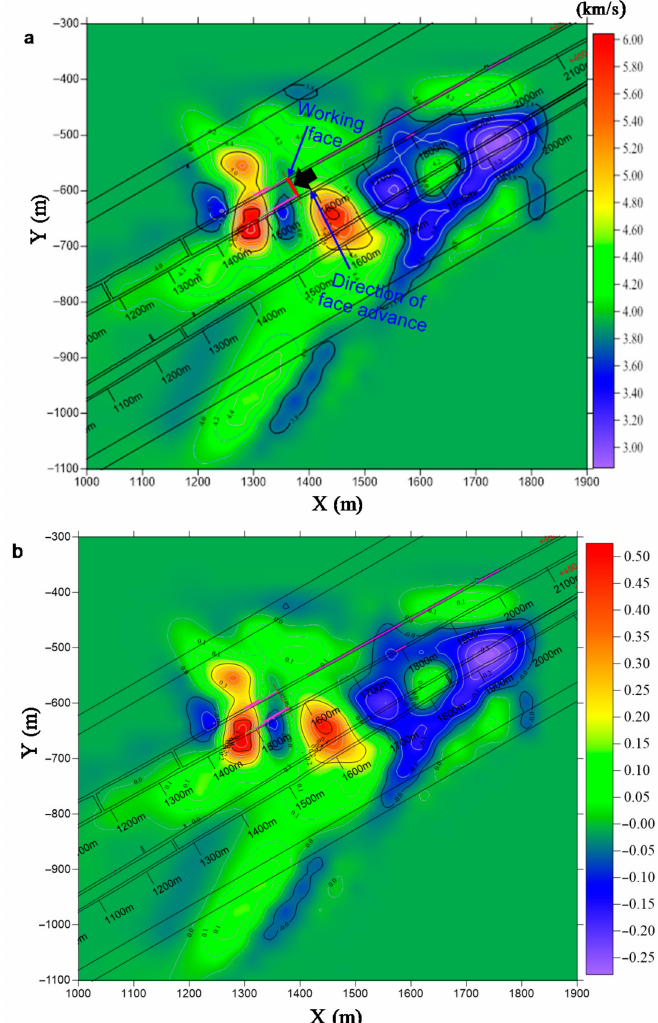
Figure 16. Tomographic images obtained using MS events on 23 April 2017 (with the 181 MS events that occurred). ( a ) Velocity inversion result, ( b ) Velocity anomaly inversion